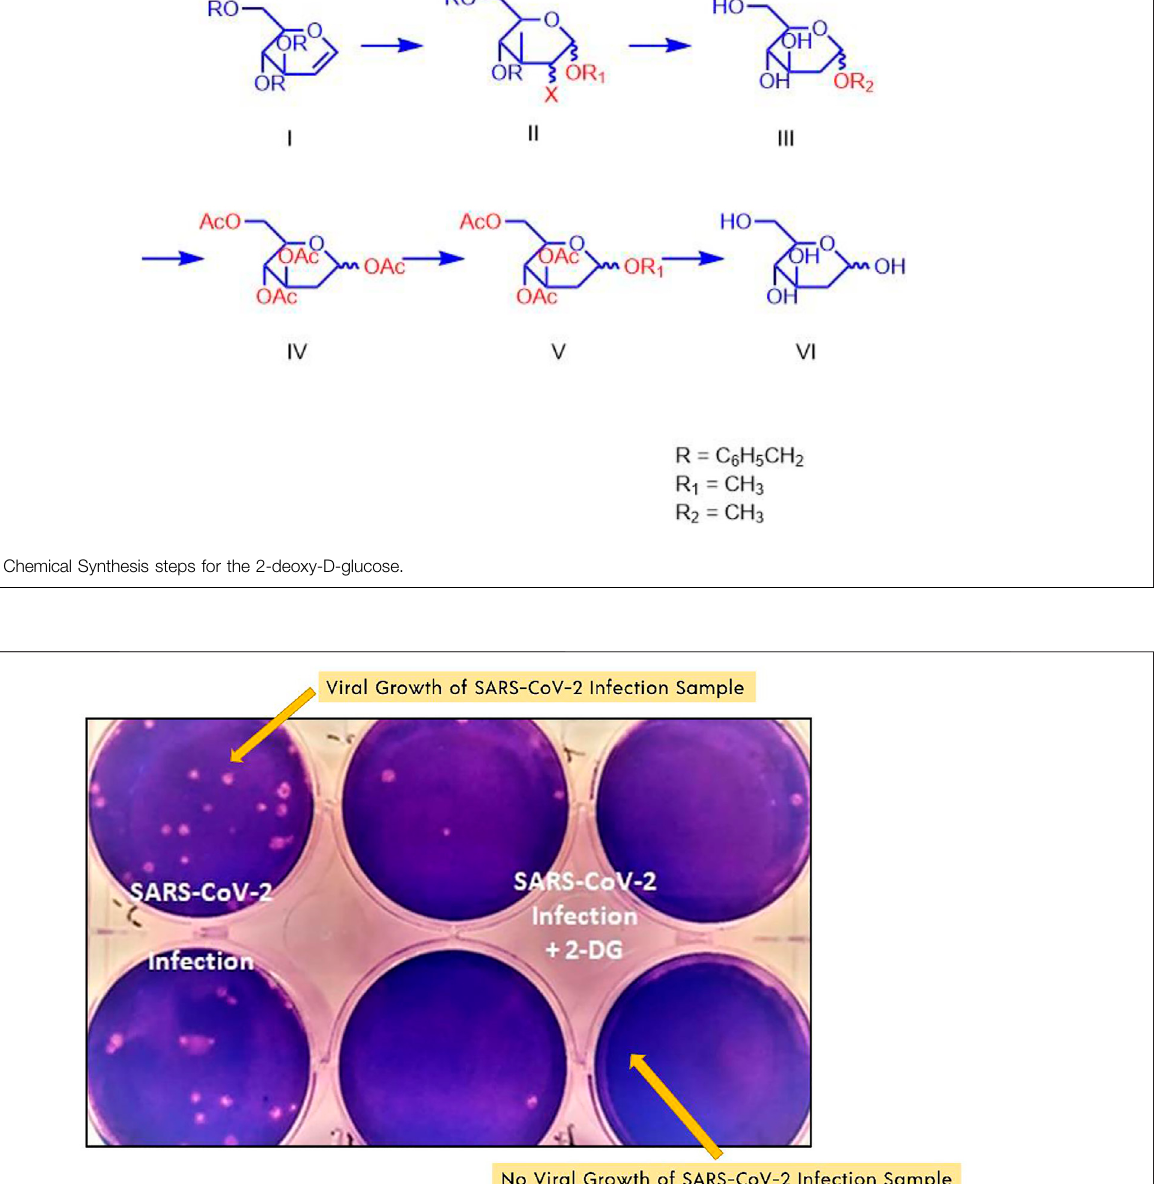
Frontiers in Pharmacology |